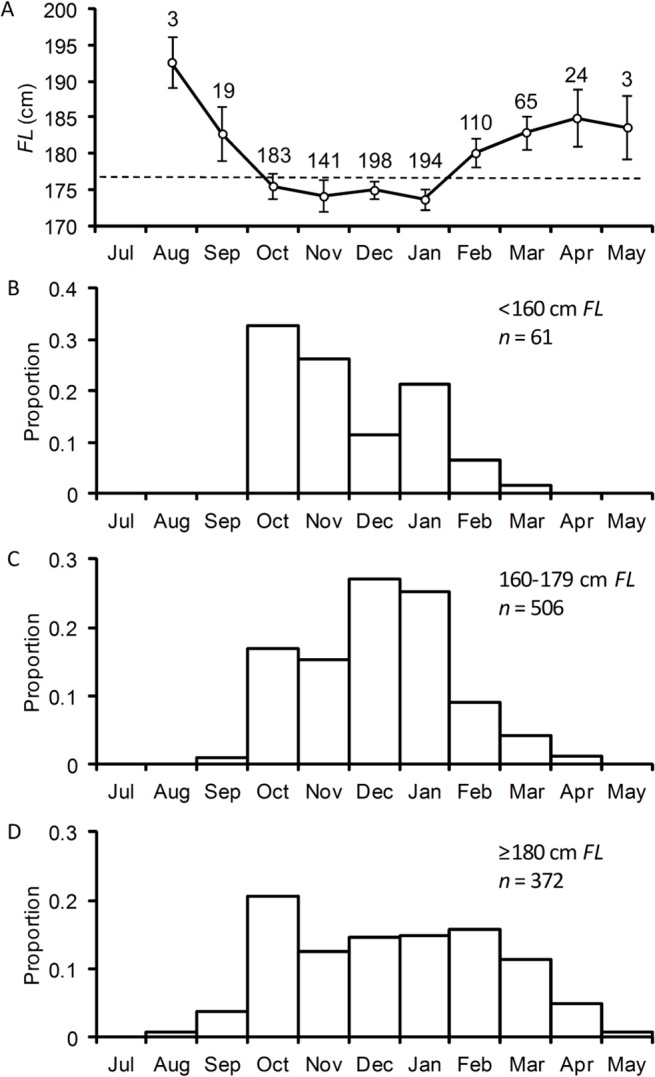
Seasonal variation in the size of southern bluefin tuna caught on the spawning ground.(A) Mean FL ± 2 S.E. by month; sample sizes are shown above the mean and the dashed line indicates the mean for all females (176.3 cm FL). (B-D) Proportion of fish sampled by month for three length class.